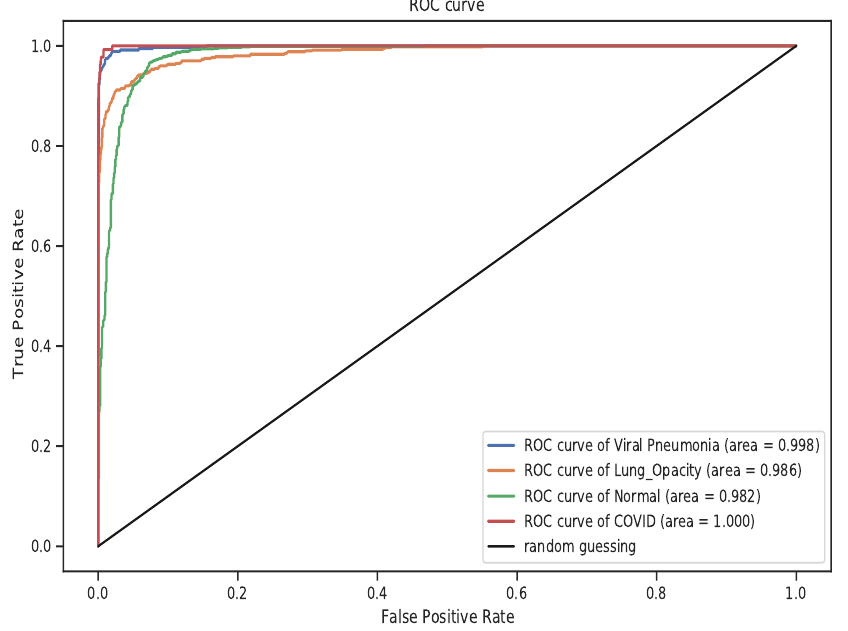
Figure 12. The Receiver Operator Characteristic Curve (ROC) where COVID-19 class obtained the high Area Under the Curve (AUC) of